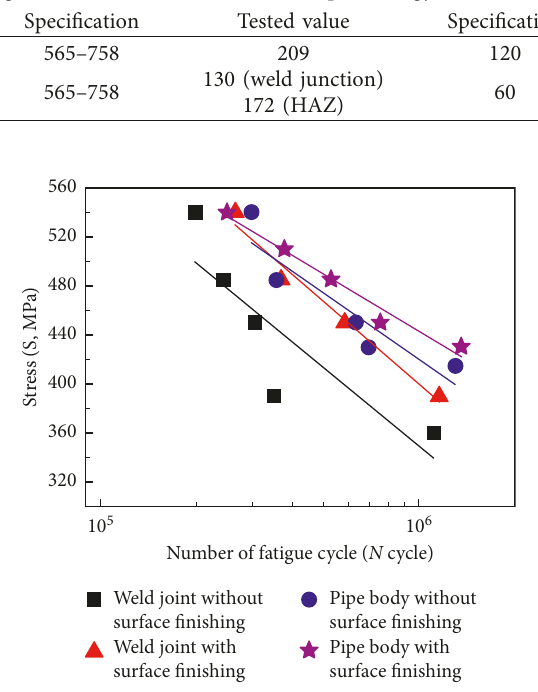
Figure 3: Stress-number of fatigue cycle curves evaluated at R � 0.1, 10Hz, and room temperature for the pipe body and the welded joint with and without surface